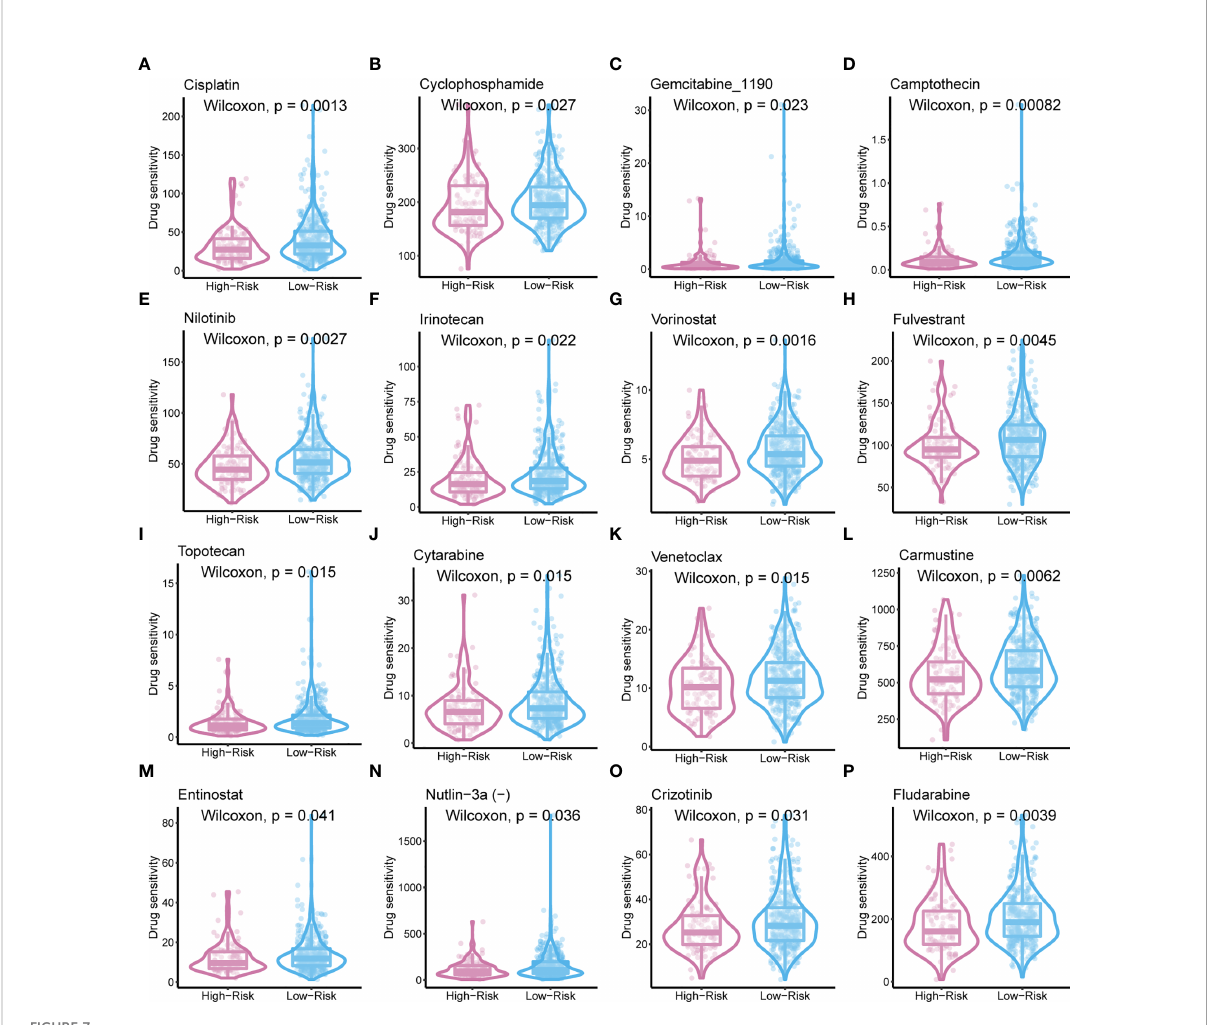
FIGURE 7 The sensitivity of 16 common chemotherapy drugs between MetaScore groups in PCa